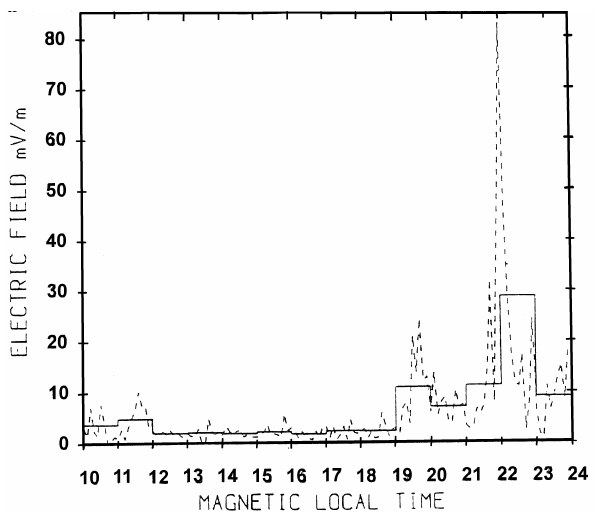
Fig. 1. The 6-minute values (E6) (broken line) and 60-minute av- erages (E60) (solid line) of the electric field over Tromsø, Norway as measured by the EISCAT radar on 5 September 1989. Magnetic Local Time is about UT+1.